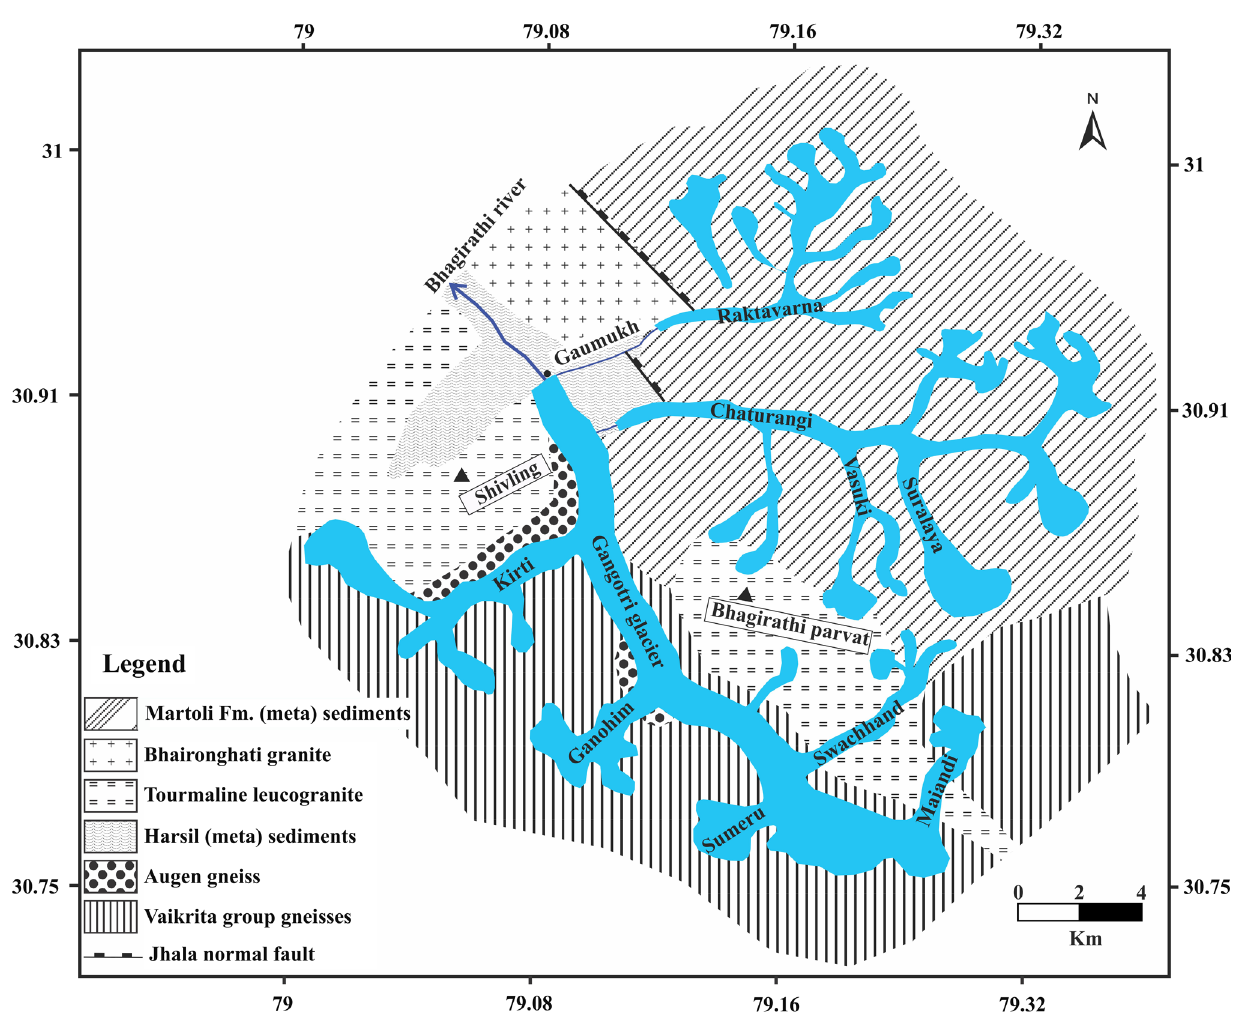
Fig. 3 A simplified geological map of the upper reaches of Bhagirathi basin close to the glacier (modified after Searle et al.